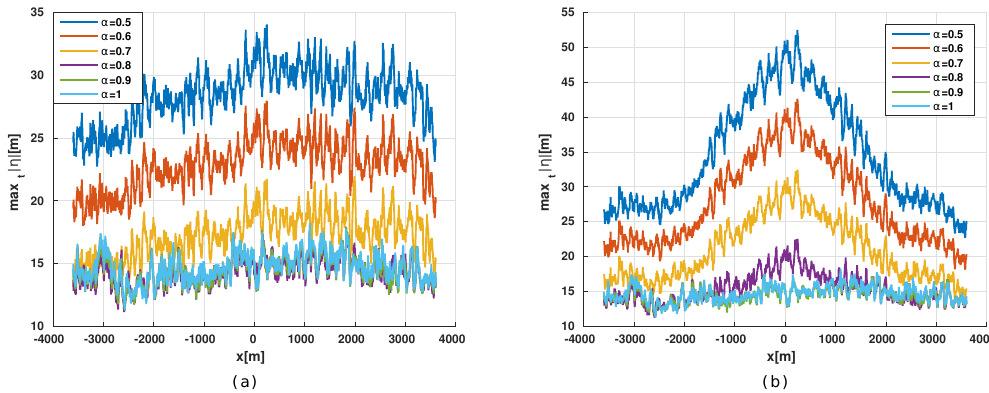
Figure 3. The maximal temporal amplitude of the linear evolution of the wpm signal for various values of α . Panel (a) corresponds to restricting the phases to a quarter SD, | ω − ω p | < 0 . 25 σ ω and (b) for a half SD, | ω − ω p | < 0 . 5 σ ω .